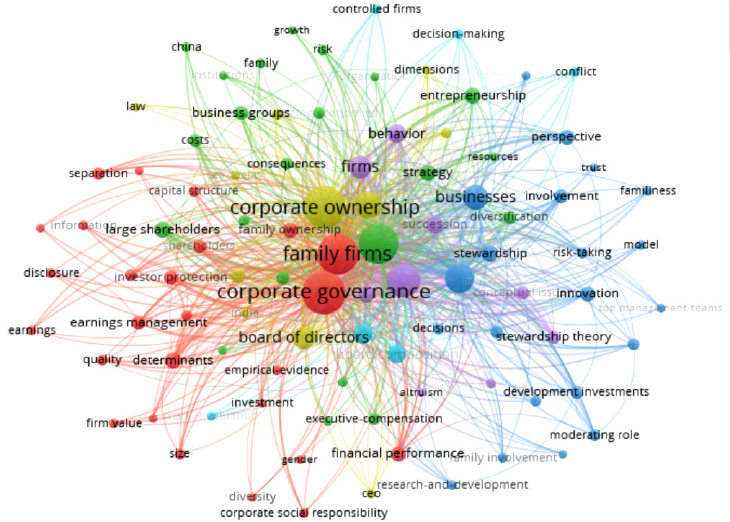
Figure 9. The co-occurrence network of